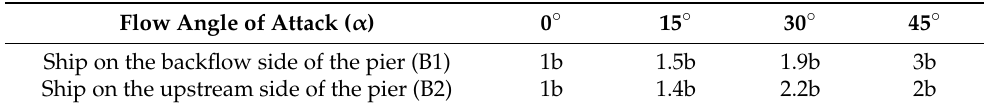
Figure 34. Transverse velocity distribution of flow around a round-ended pier with different flow angles of attack: ( a ) α = 0°; ( b ) α = 15°; ( c ) α = 30°; ( d ) α = 45°. Table 6. Navigation limits of the width of the water area on either side of a round-ended pier with different flow angles of attack.